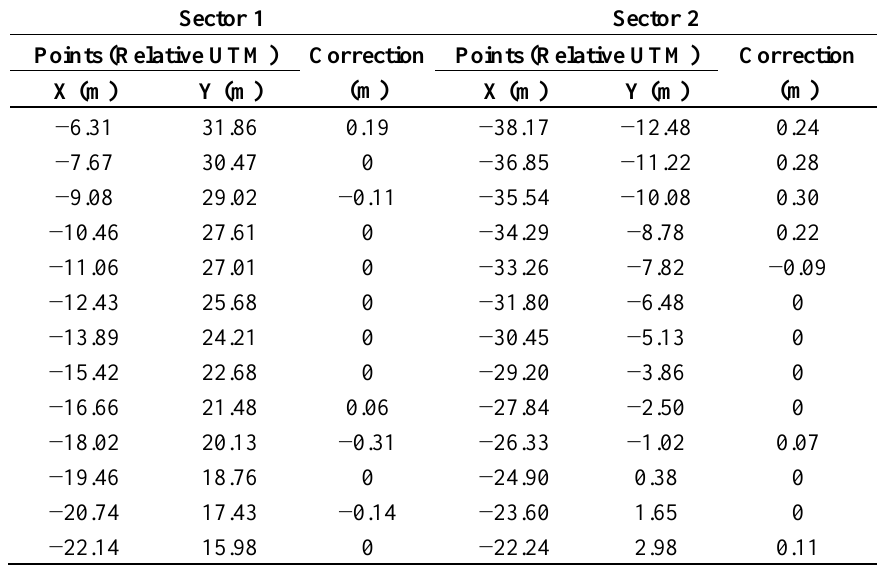
Table 6. Relative UTM positions where the perception system generated an output correction